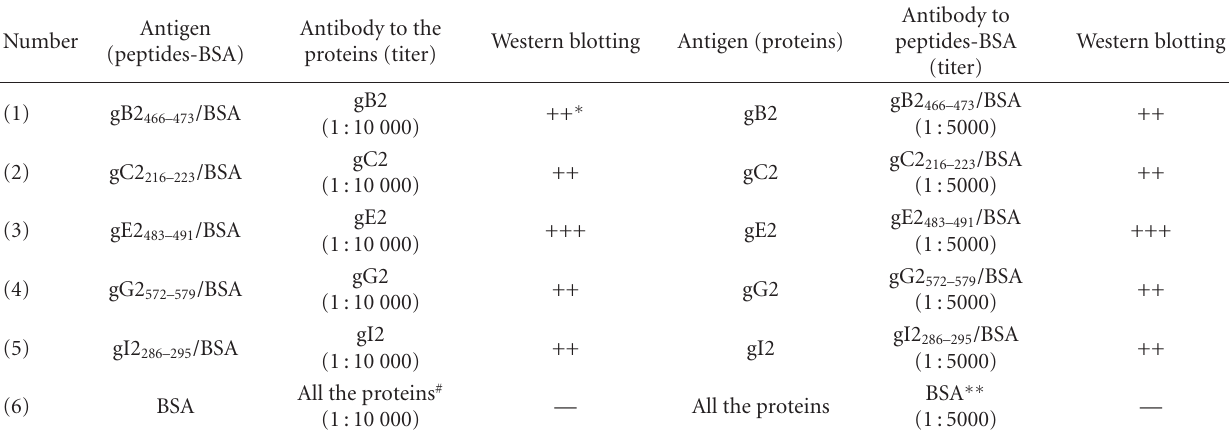
Table 3: Antigenicity and specificity detection of the five peptides using Western Blot analysis.